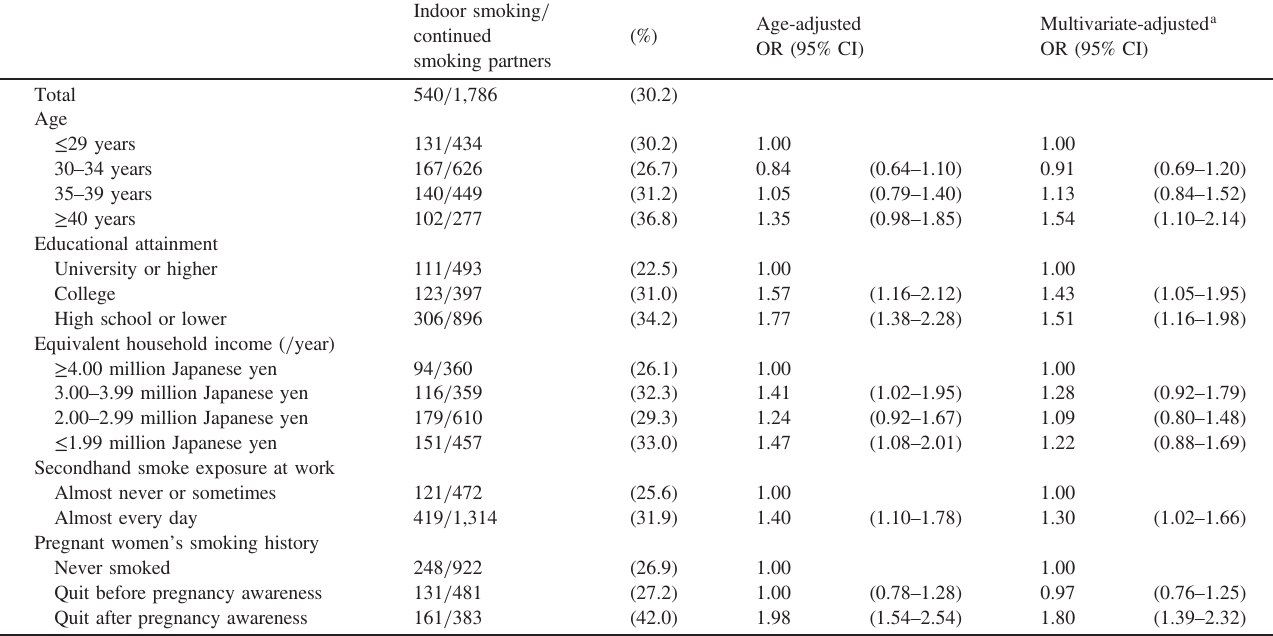
Table 3. Prevalence, odds ratios (ORs) and 95% con fi dence intervals (CIs) for indoor smoking among continued smoking partners after becoming aware of the